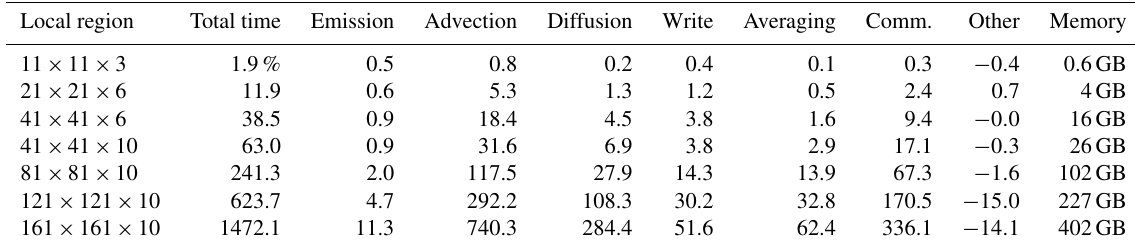
Table 1. Additional computation time needed for the calculation of local fractions in different settings, expressed in percent in comparison to the total time needed when the calculation of local fractions is not included. The first column shows the dimensions of the local region. The second column shows the total additional time required. Columns three to eight show the breakdown of those fractions into the different subroutines (“comm.” stands for communication time between compute nodes). “Other” shows the difference between total time and its components (it is principally due to uncontrolled differences in the speed of the different compute nodes). The last column shows the additional memory required in total; it has to be multiplied by the number of species or sectors requested. The total time without the calculation of local fractions in our test was 553s. Local region Total time Emission Advection Diffusion Write Averaging Comm. Other Memory 11 × 11 ×